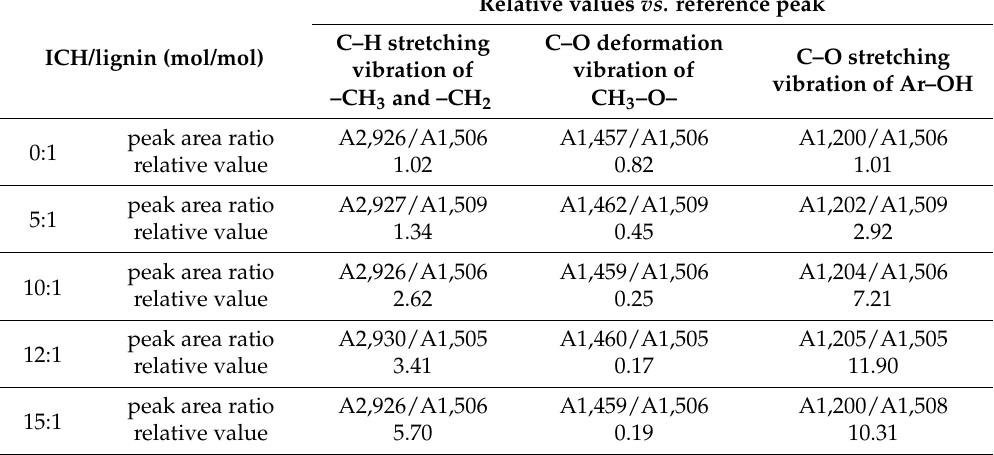
Figure 3. FTIR spectra of acetylated WSAL and D-WSAL with 0 ( a ), 5:1 ( b ), 10:1 ( c ), 12:1 ( d ) and 15:1 ( e ) molar ratio of ICH to lignin, prepared at 145 °C for 3 h with 4 mL DMF under nitrogen atmosphere. Table 1. Results of FTIR semi-quantitative analysis of the relative values of some functional groups of WSAL and D-WSAL calculated with the phenyl group’s skeleton vibration peak at 1503 cm − 1 as the reference.